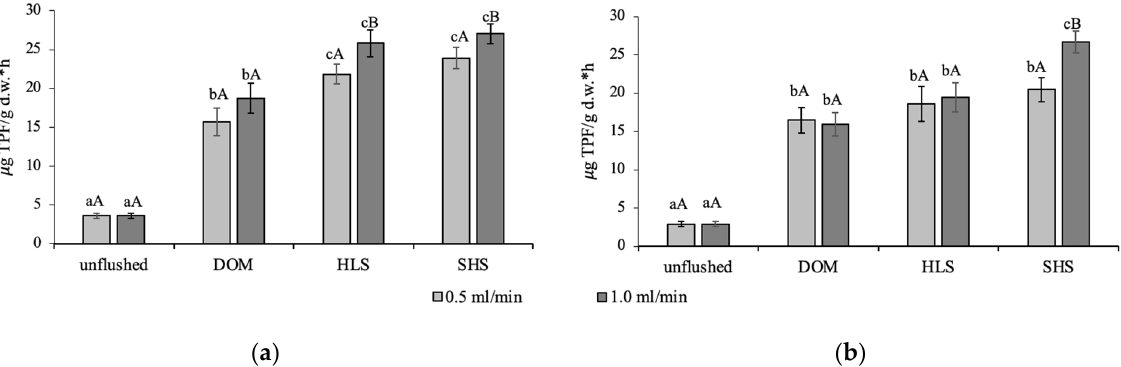
Figure 5. Dehydrogenase activity (DHA) before and after soil flushing: ( a ) S1, ( b ) S2. Significant differences ( p < 0.05) between tested washing agents are marked with small letters, while between different flow rates are marked with large letters.